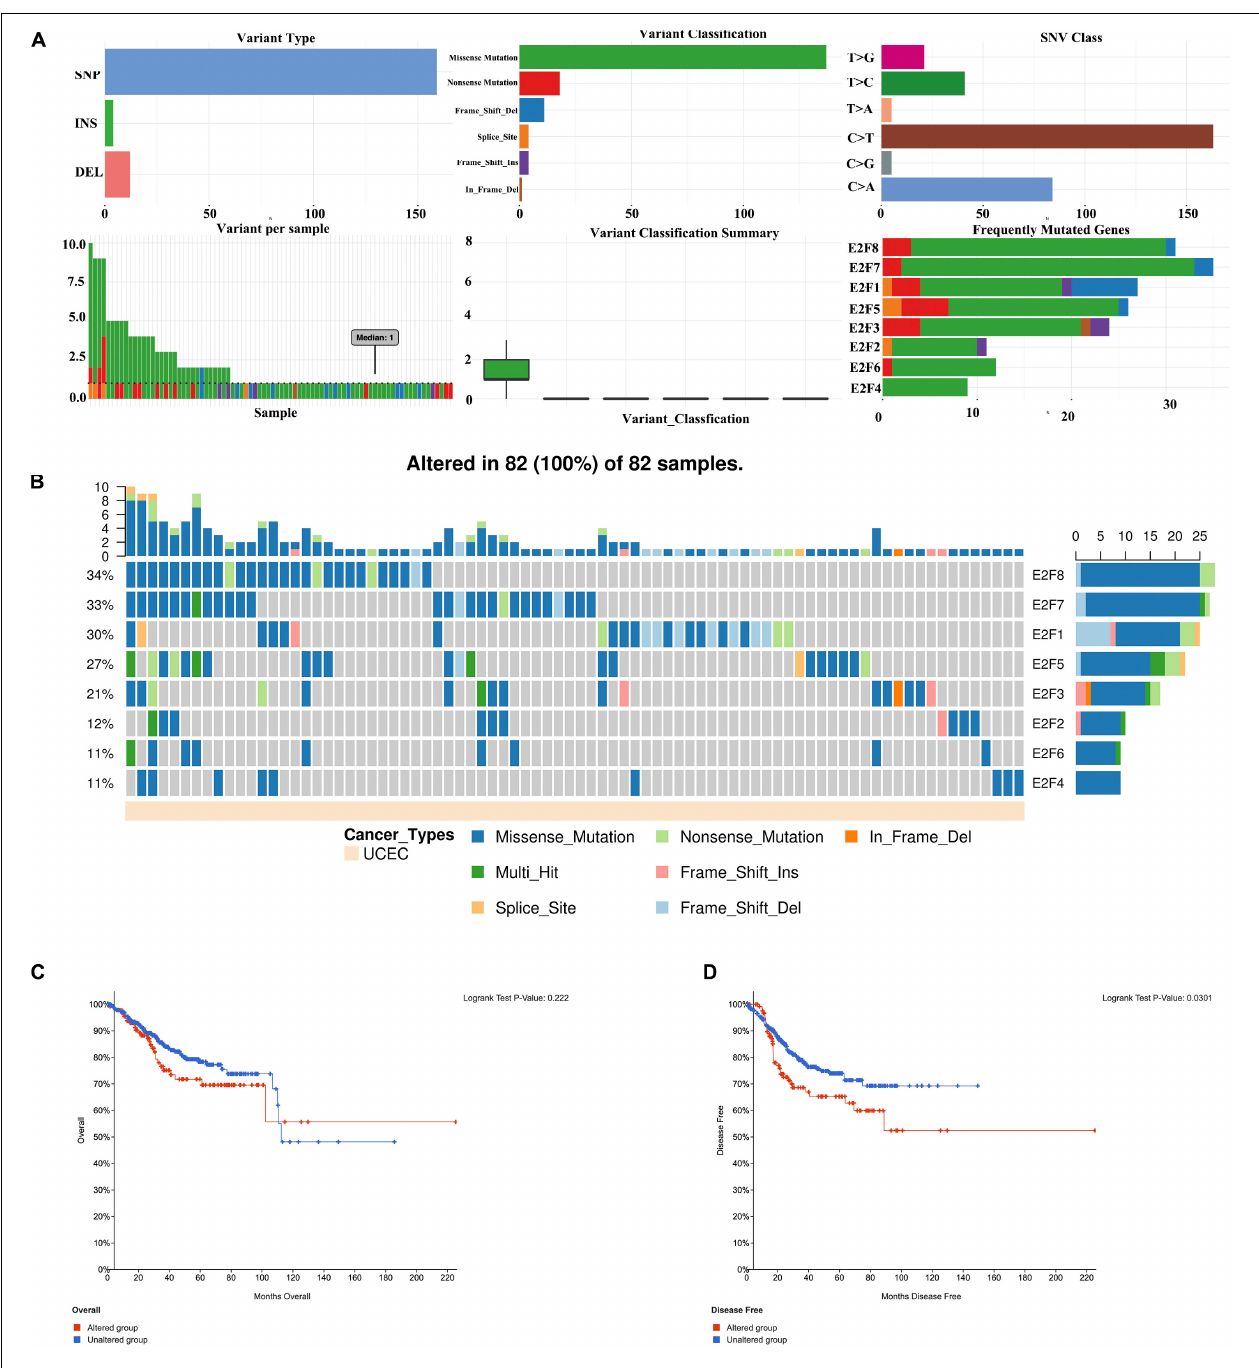
FIGURE 8 | The genetic alteration in E2Fs in UCEC. (A) Plot displays for genetic alteration frequency and variant types of E2Fs in UCEC. (B) Waterfall plot for the distribution and classification of genetic alteration in E2Fs in UCEC. (C,D) The effect of E2Fs on the genetic alteration and corresponding prognosis of UCEC